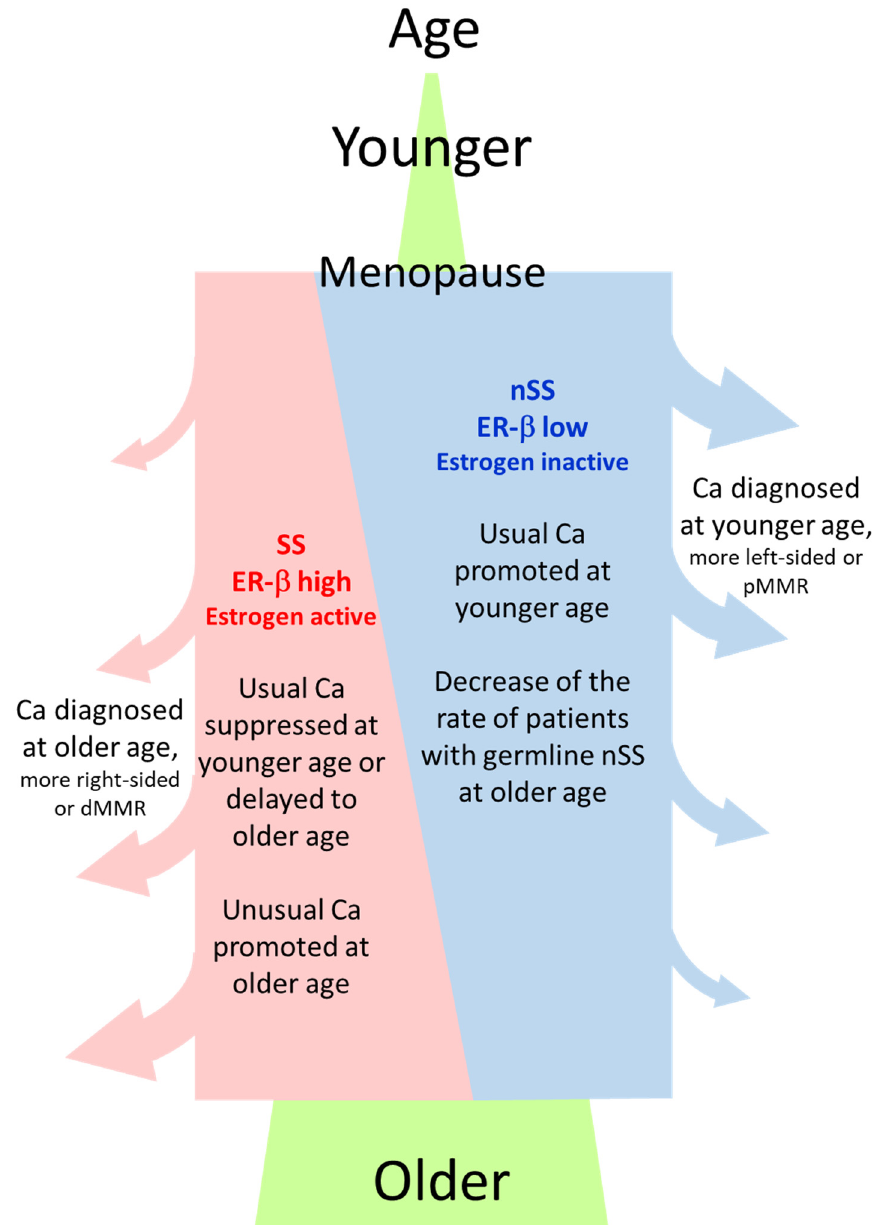
Figure 6. General image of the relation between ESR2 -CA genotype (SS or nSS) in NonCa, age at cancer diagnosis, and cancer type. ‘Usual Ca’, having characteristics such as left-sided or pMMR, is suppressed by estrogen, whereas ‘unusual Ca’, having characteristics such as right-sided or dMMR, is promoted by estrogen. Postmenopausal women with nSS genotype and lower ER- β expression in NonCa have a higher risk of usual Ca at a younger age, contrasting with those with the SS genotype, where more Ca are diagnosed at an older age due to slow onset/development of the disease. Ca, cancerous tissue; NonCa, non-cancerous tissue; dMMR, mismatch repair protein (MMR)-deficient; pMMR, MMR-proficient.